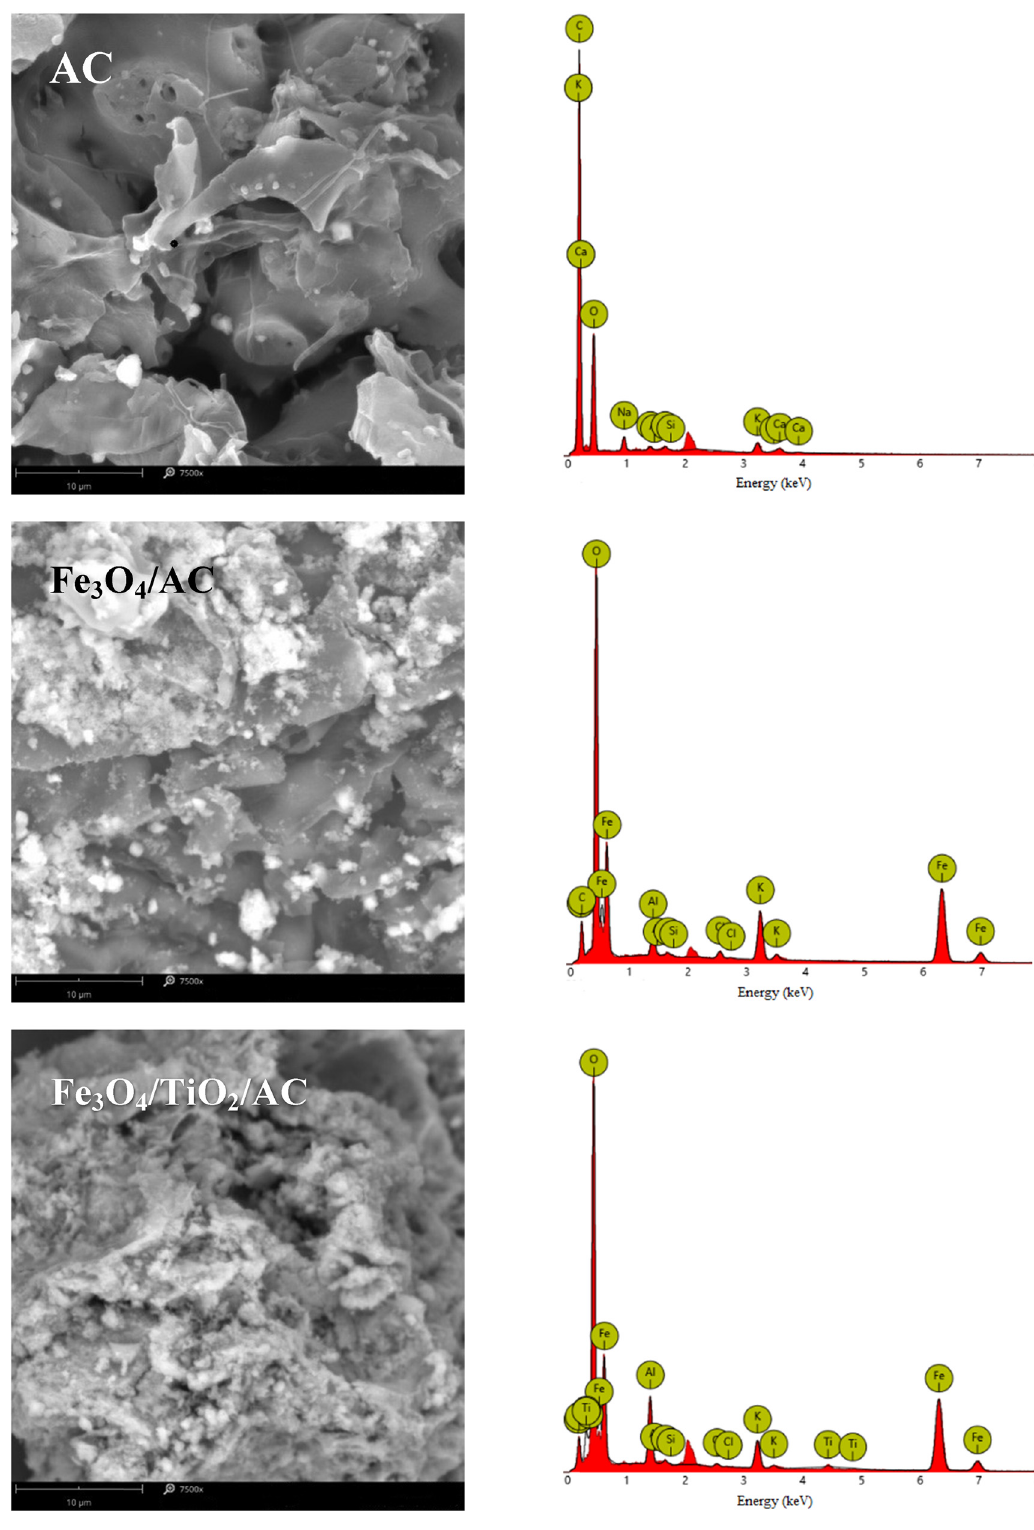
Figure 4: SEM - EDX pro fi le of